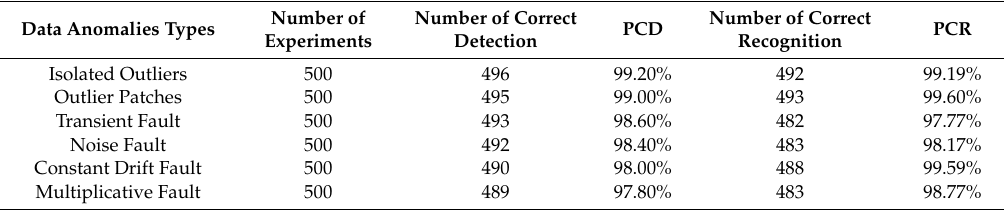
Table 7. Simulation experiment statistics of the new method.